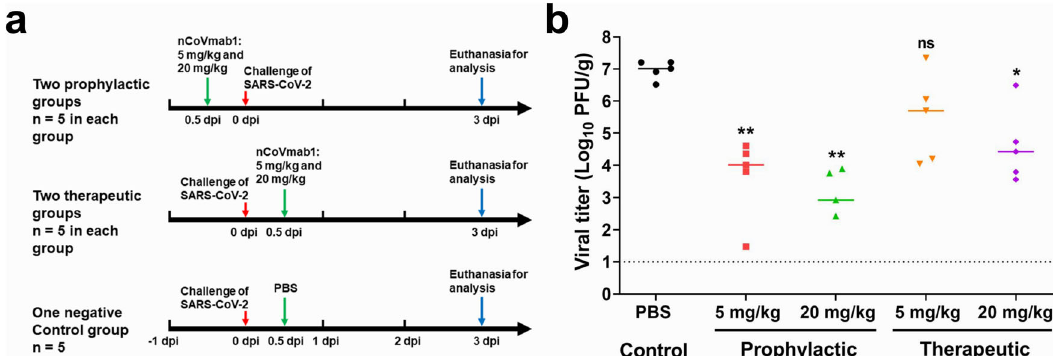
Fig. 3 Protective ef fi cacy of nCoVmab1 in vivo. a Experimental route of prophylactic and therapeutic tests of nCoVmab1 in hACE2 transgenic mice. hACE2 transgenic mice were intraperitoneally injected with low (5 mg/kg, n = 5 mice/group) and high (20 mg/kg, n = 5 mice/group) doses of nCoVmab1 12 h before or 12 h after SARS-CoV-2 infection. PBS was used as a negative control ( n = 5 mice/group). b The viral titers in the lungs from different groups were determined at 3 dpi by plaque assay (dashed line represents the detection limit). The median values were presented. In the high-dose prophylactic group, one mouse had a viral titer below the detection limit. Statistical signi fi cance was measured by using one-way ANOVA with Dunnett ’ s multiple comparisons, not signi fi cant [ns]: p > 0.05, * p < 0.05, ** p < 0.01. For the prophylactic experiment in b , p value between the PBS group and the low